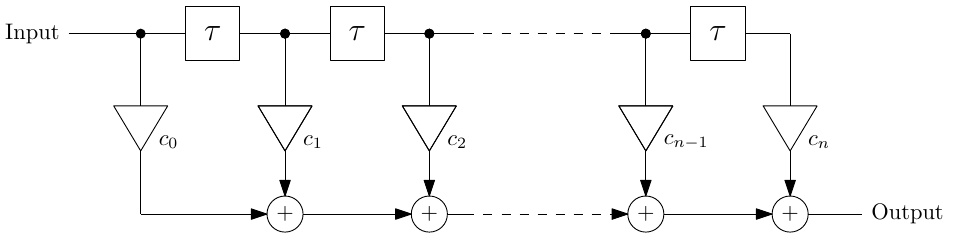
Figure 5. Block diagram of a n tap FFE.